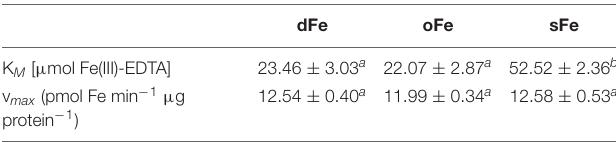
TABLE 3 | Parameters of the ferric chelate reductase (FCR) activity of the inner envelope fraction of chloroplasts calculated as Boltzmann sigmoidal fit on enzyme activity data in the function of substrate